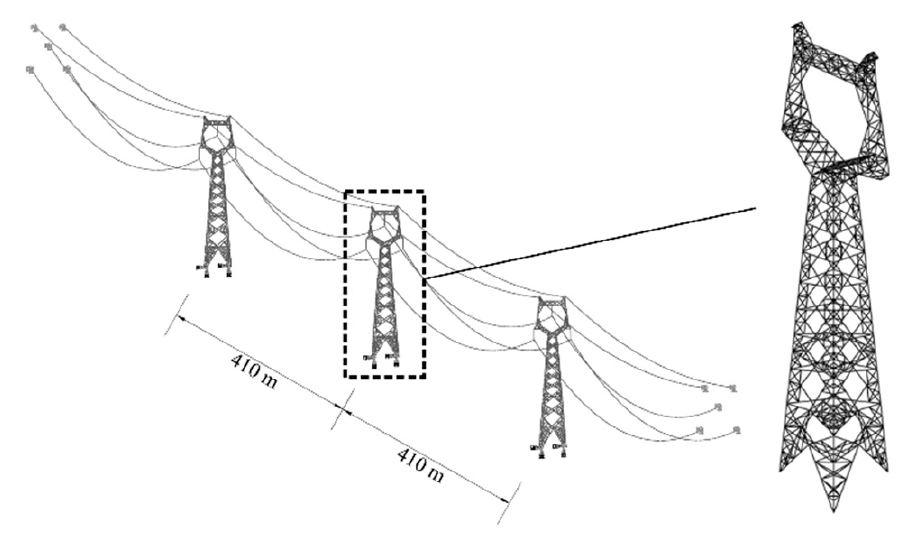
Figure 4. Finite element model of the structure.